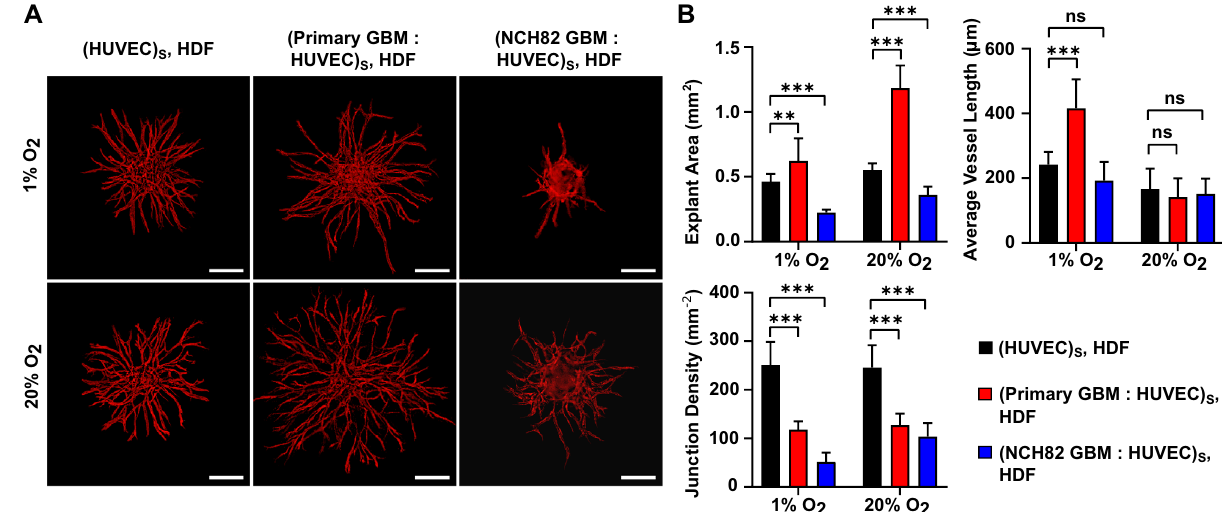
Figure 2. Angiogenic sprouting of HUVEC under various culture conditions at day 3 after seeding cultured at 1% and 20% O 2 . ( A ) Red fluorescence channel images showing sprouting of HUVEC spheroid with HDF, and primary or NCH82 GBM : HUVEC spheroid with HDF. HUVEC are shown in red. HDF and GBM cells are not visible. The spheroids and single HDF cells are embedded in a 7.5 mg/mL fibrin gel. The scale bars represent 200 µ m. ( B ) Graphical representations of the explant area, average vessel length and junction density. Data are presented as the mean ± standard deviation; n = 3; * p < 0.05, ** p < 0.01, *** p < 0.001. Subscript S denotes cells seeded in the same spheroid.